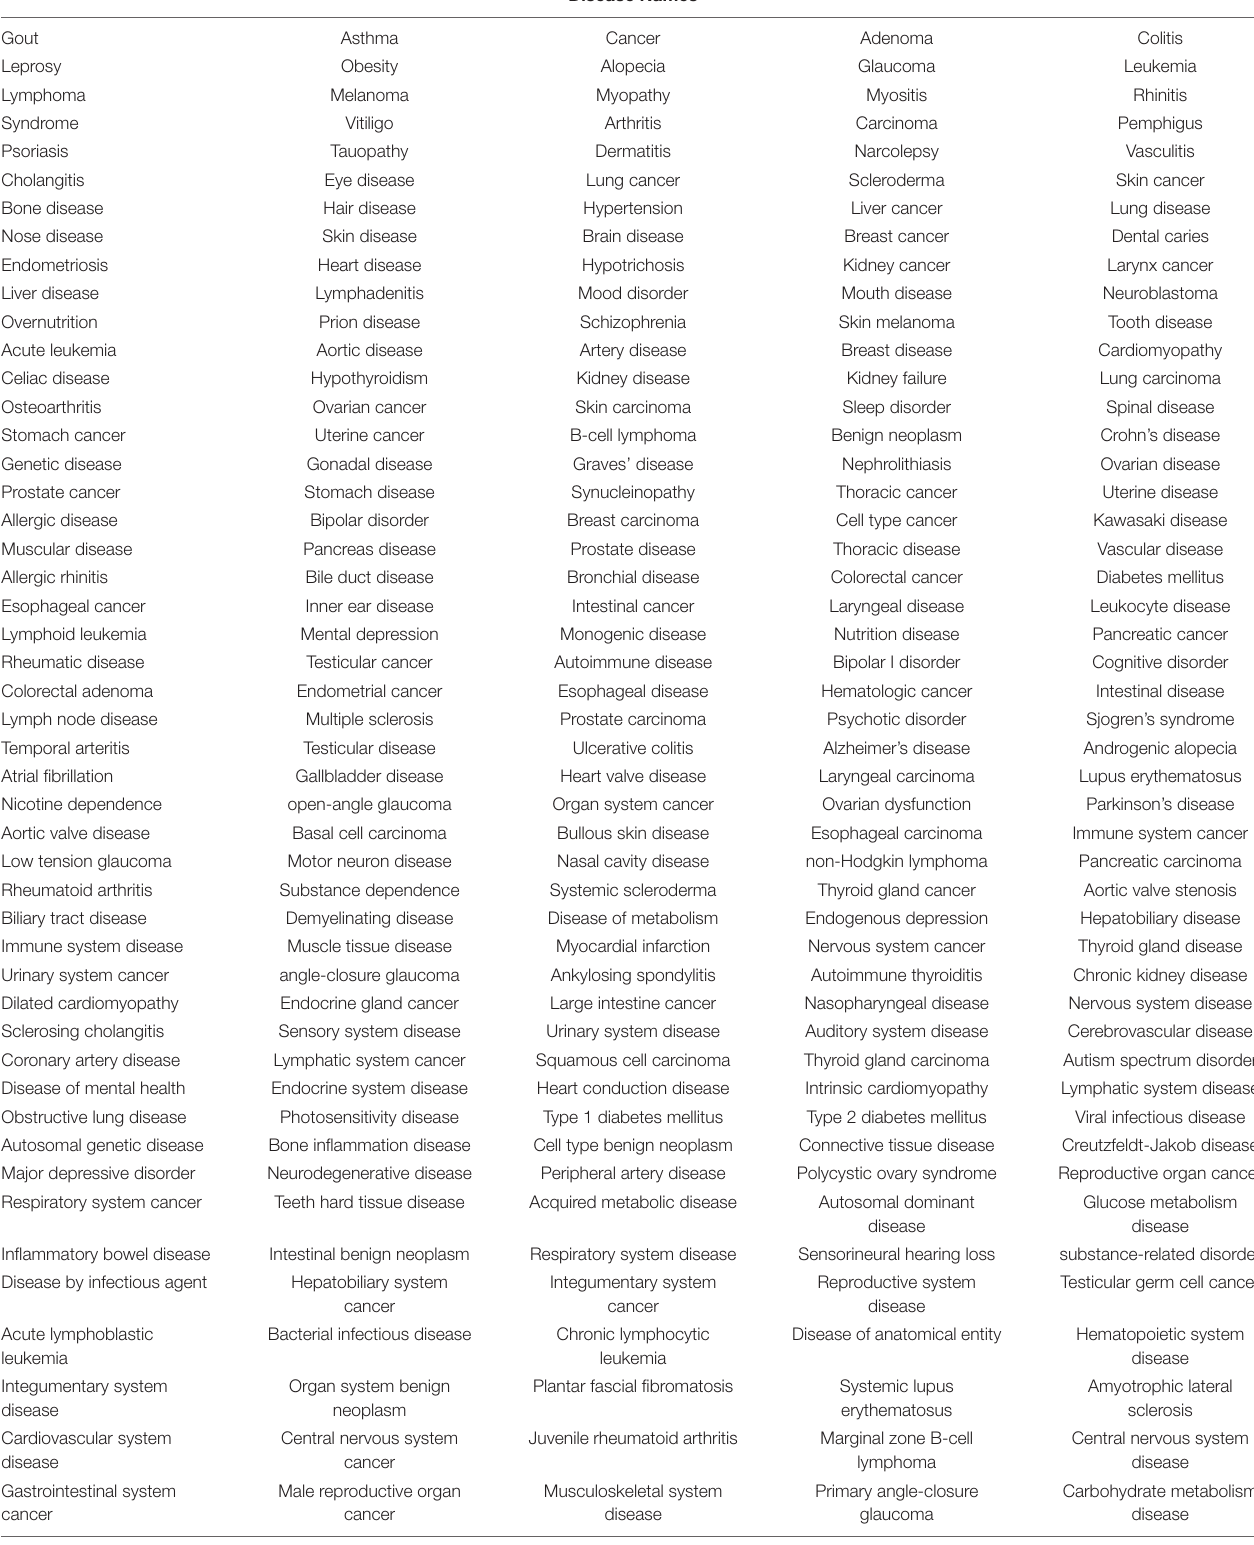
TABLE 2 | Key diseases in which the genes that are maximally regulated in muscle atrophy are